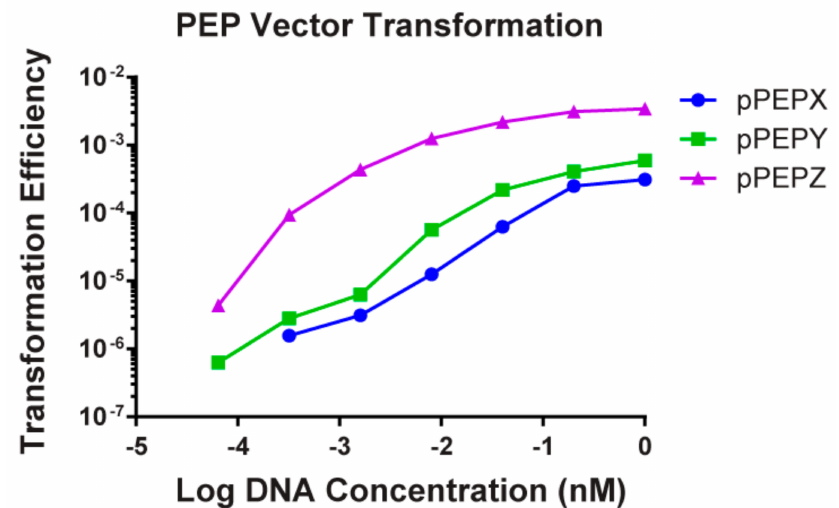
Figure 3. Transformation e ffi ciencies of the various PEP vectors. The three PEP vectors, pPEPX, pPEPY, and pPEPZ were tested for transformation into the S. pneumoniae strain D39V. All vectors were transformable into D39V with a dose dependent response based on the amount of DNA added up to a saturation point. At all concentrations of DNA, pPEPZ had the highest transformation e ffi ciency with pPEPX and pPEPY displaying similar rates of transformation and homologous